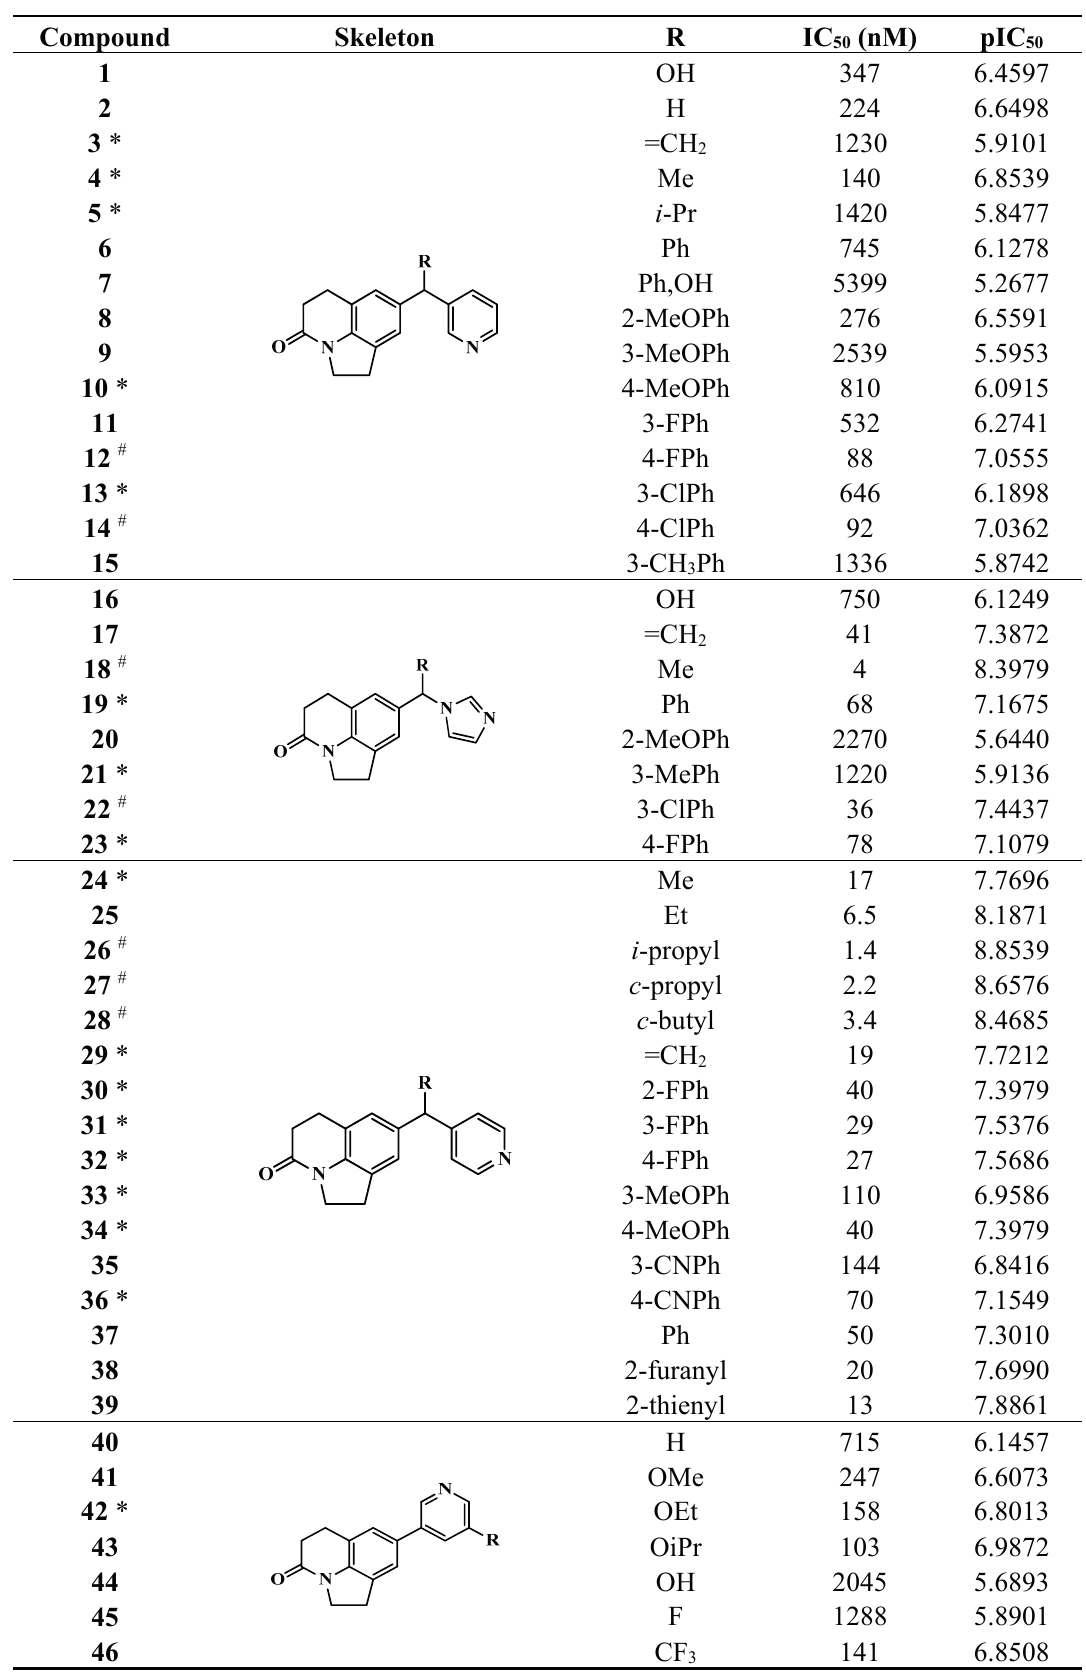
Table 3. The structures and bioactivity values of active